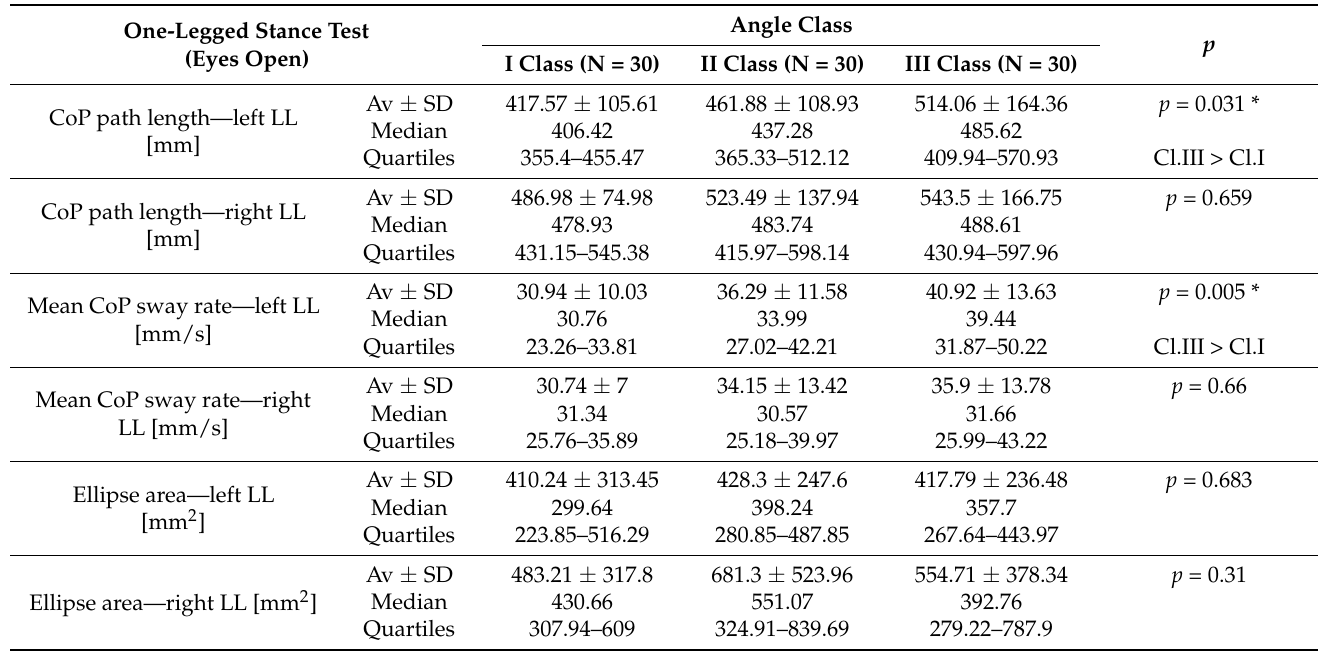
Table 5. Results of selected stabilographic examination parameters (one-legged stance test, eyes open) in groups with I, II and III Angle Class.